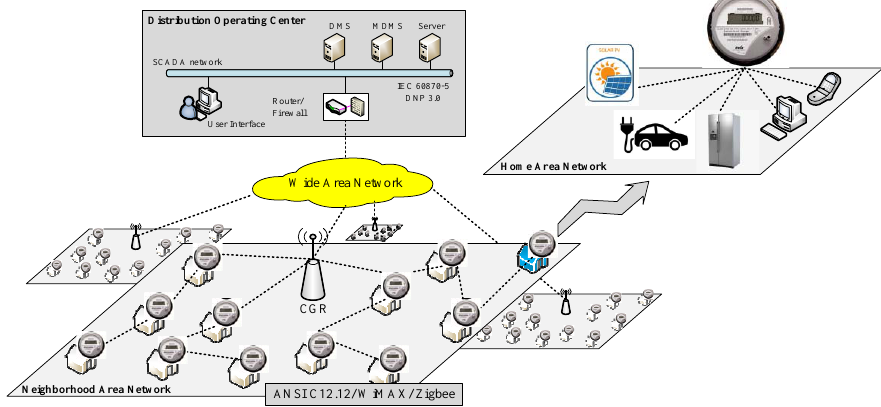
Figure 3. Architecture of an AMI system.